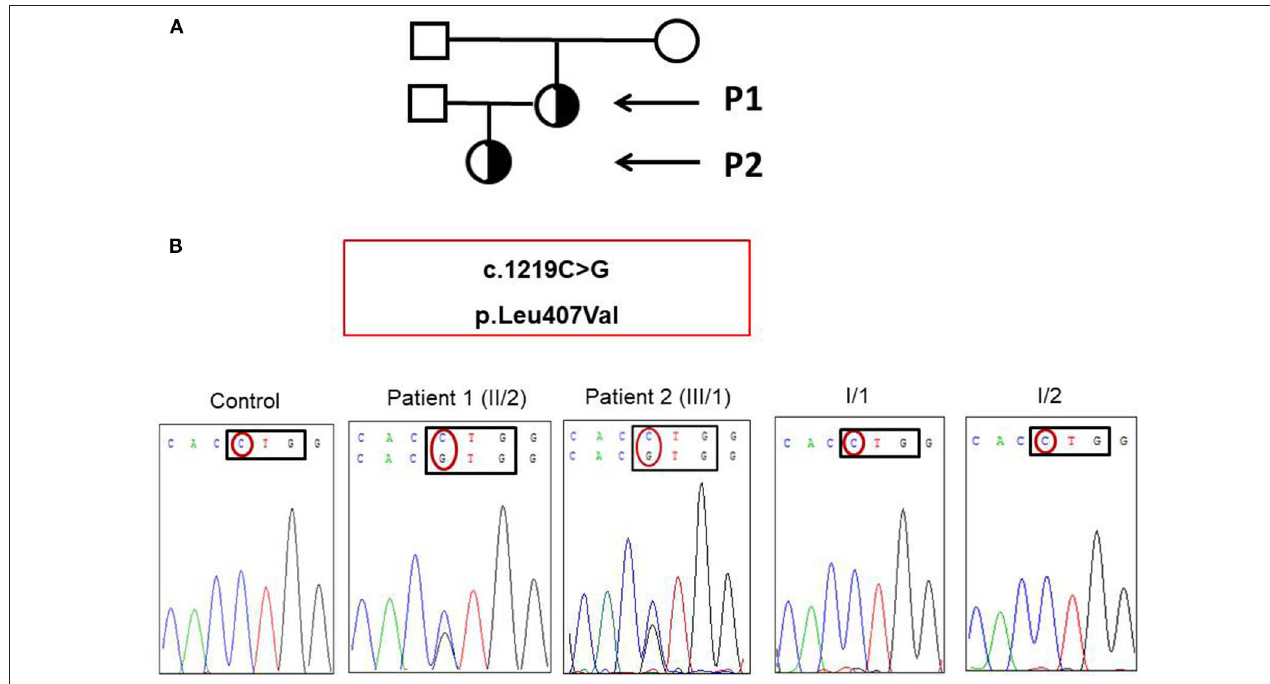
FIGURE 2 | (A) Pedigree of patient 1 and patient 2 (black arrows). (B) Novel heterozygous mutation affecting the DNA binding domain of STAT1 was detected in the patient and her